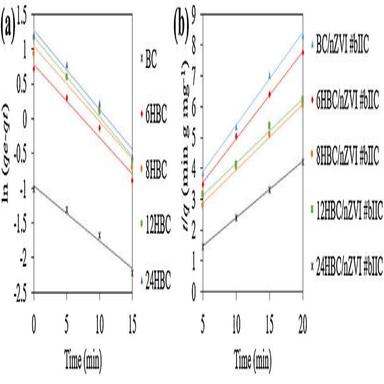
Kinetics of pNDA bleaching described by (a) pseudo-first order model for using raw BC and various HBCs; and (b) pseudo-second order model for using BC/nZVI and various HBC/nZVIs, synthesized under the optimized conditions.